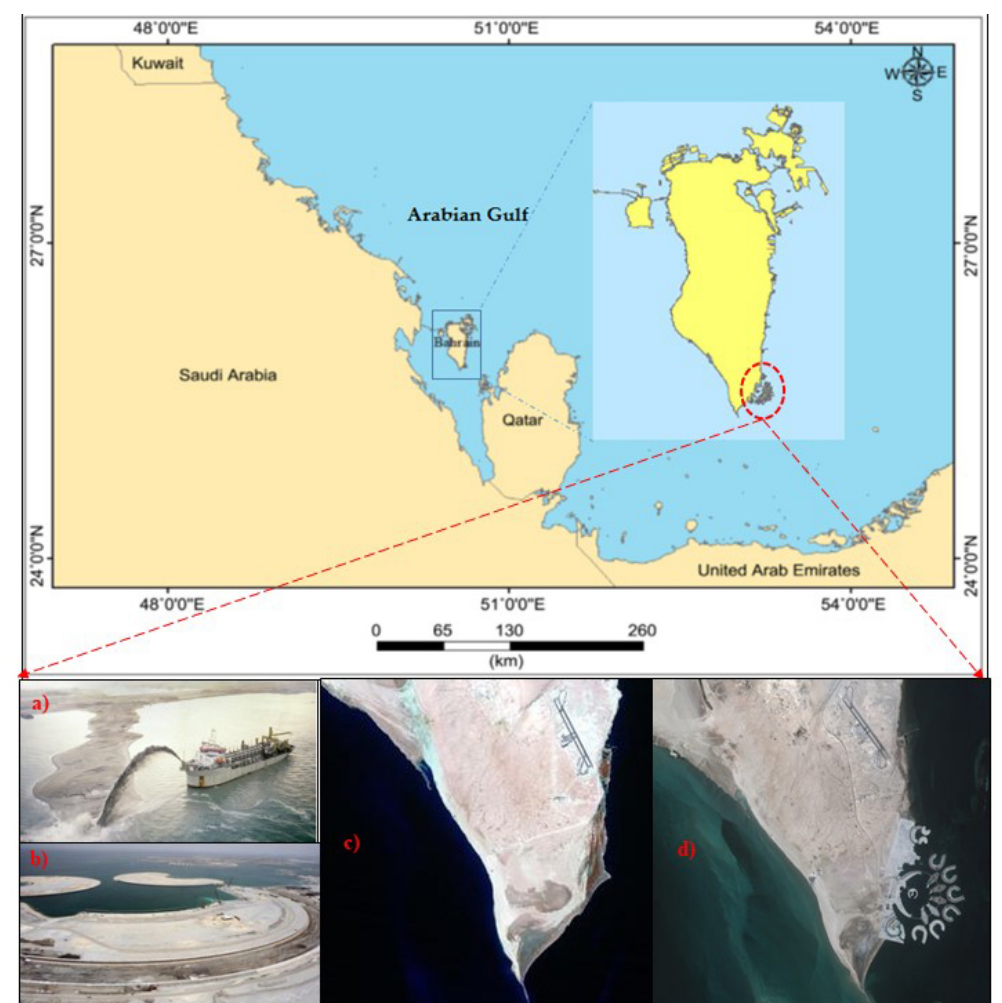
Figure 3. Study site (Kingdom of Bahrain), with photos illustrating landfill operations (a, b) , and satellite images of the south part of Bahrain before (c) and after (d) artificial island